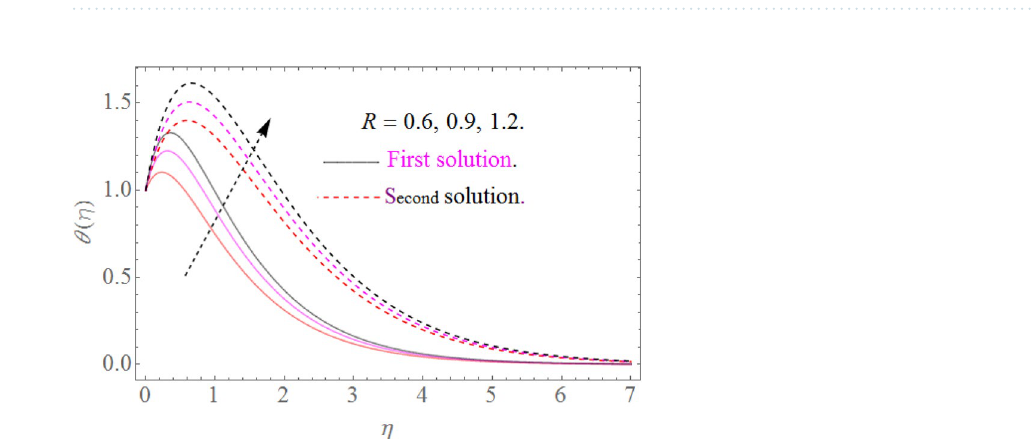
Figure 8. Influence of Pr on θ(η) for R = 0.3, θ w = 1.2 .